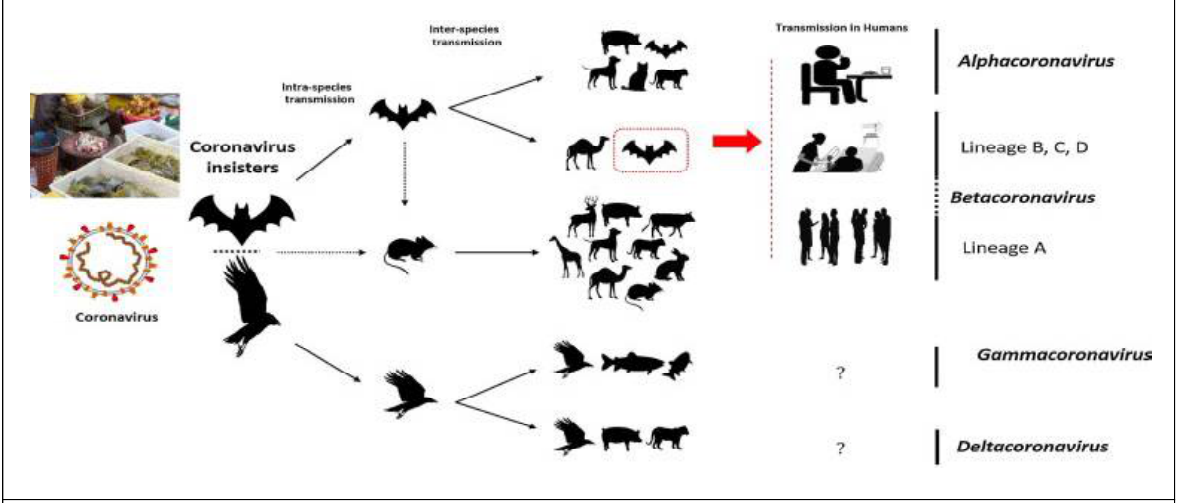
Figure 1: The life cycle of coronaviruses transmission including MERS-CoV, SARS-CoV, and COVID-19. The virus transmission to humans occurs by direct contact with infected animals. The continuous line represents direct